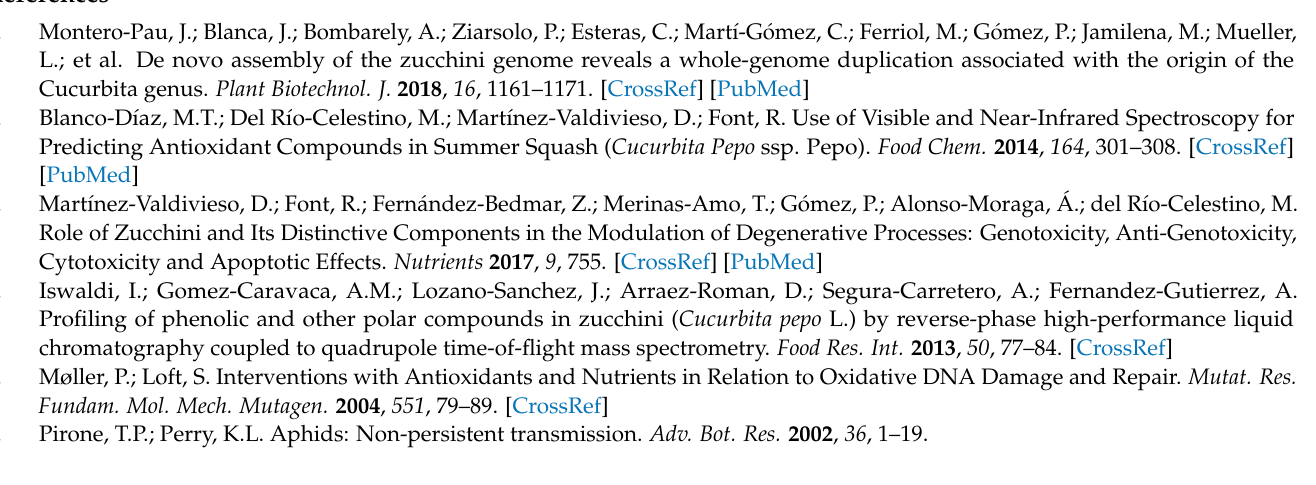
Table S3 Characteristics of atmospheric conditions during the experiment in 2019; Table S4. Table S4 Characteristics of atmospheric conditions during the experiment in 2020 and Table S5. Table with mean values obtained for powdery mildew assessment and DSI calculation and for DSI values calculated viral